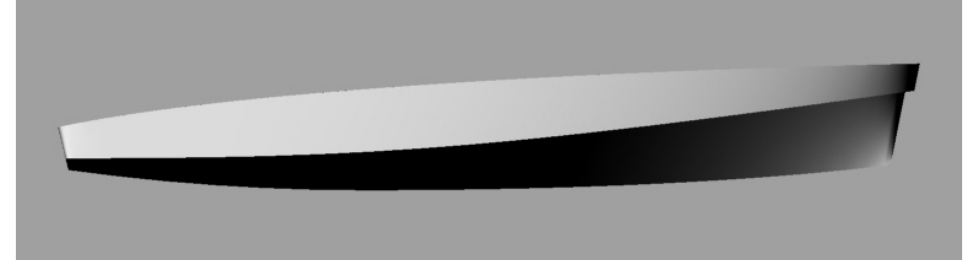
Figure 8. The KISS prototype’s first hull form with a modified bow and forebody.